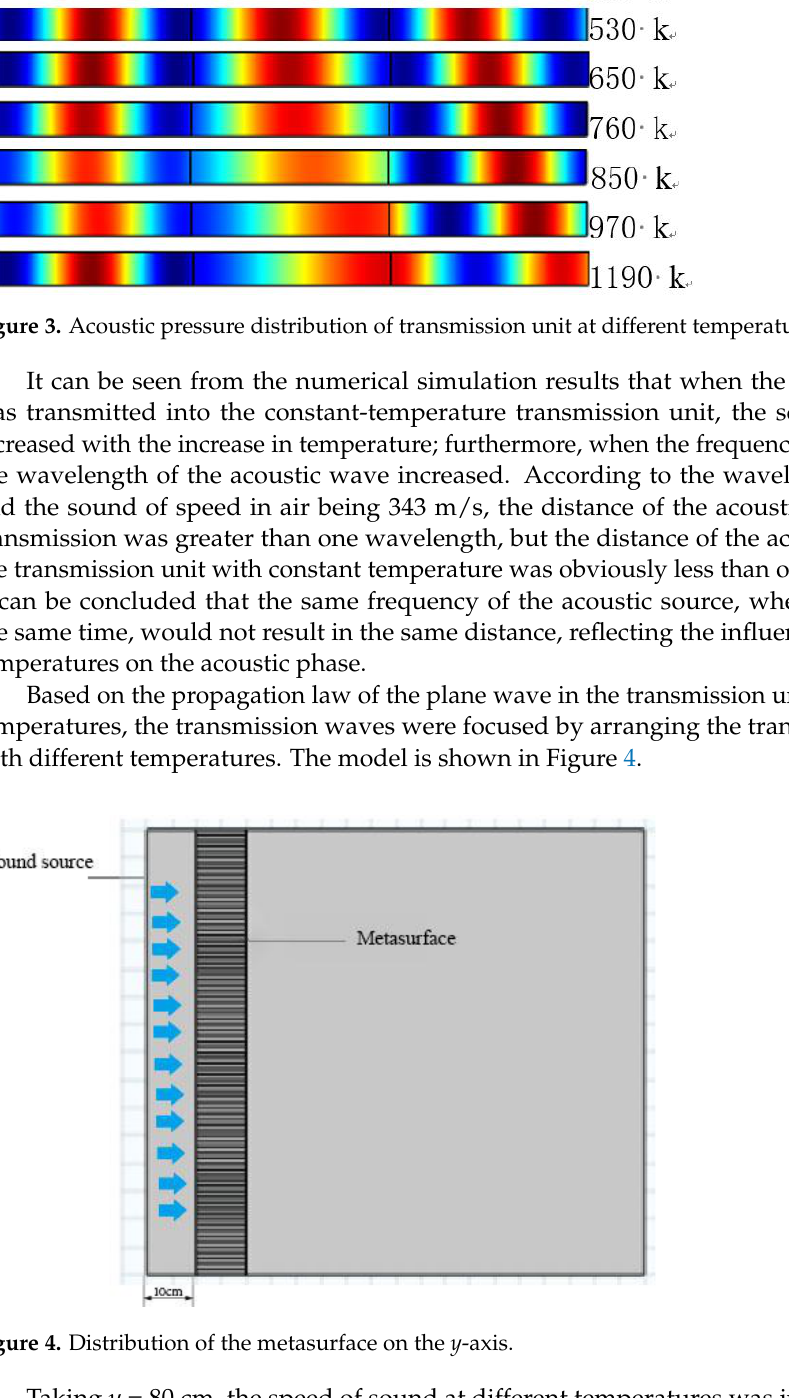
of 430 k, 530 k, 650 k, 760 k, 850 k, 970 k and 1190 k corresponded to phase delays of 7 π /4,3 π /2,5/4 π , π ,3 π /4, π /2, and π /4, respectively, as shown in Figure 5. It can be